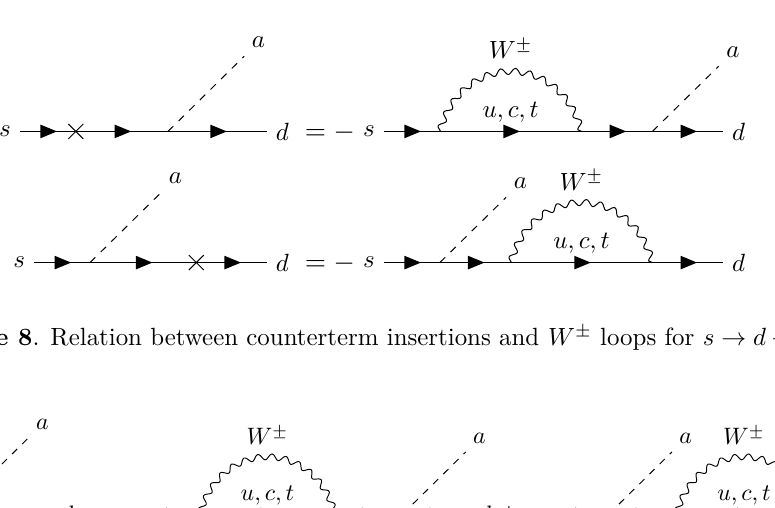
Figure 7 . Sum of counterterm-induced diagrams for s → d + a adding up to zero.